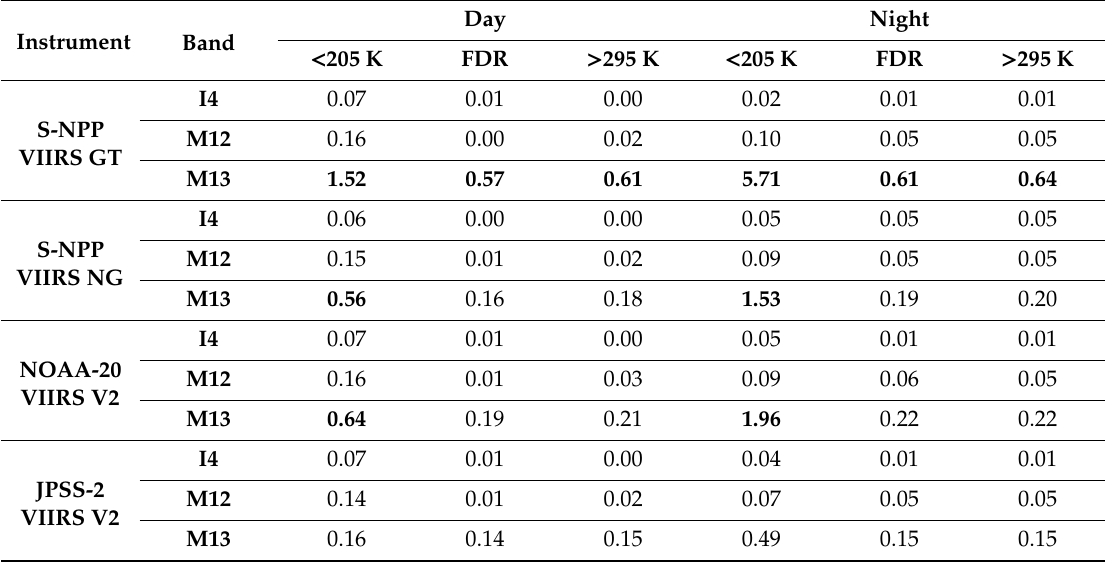
Table 12. Same as Table 11, except separated by day and night, and based only on measured 1% extended bandpass limits for bands I4, M12, and